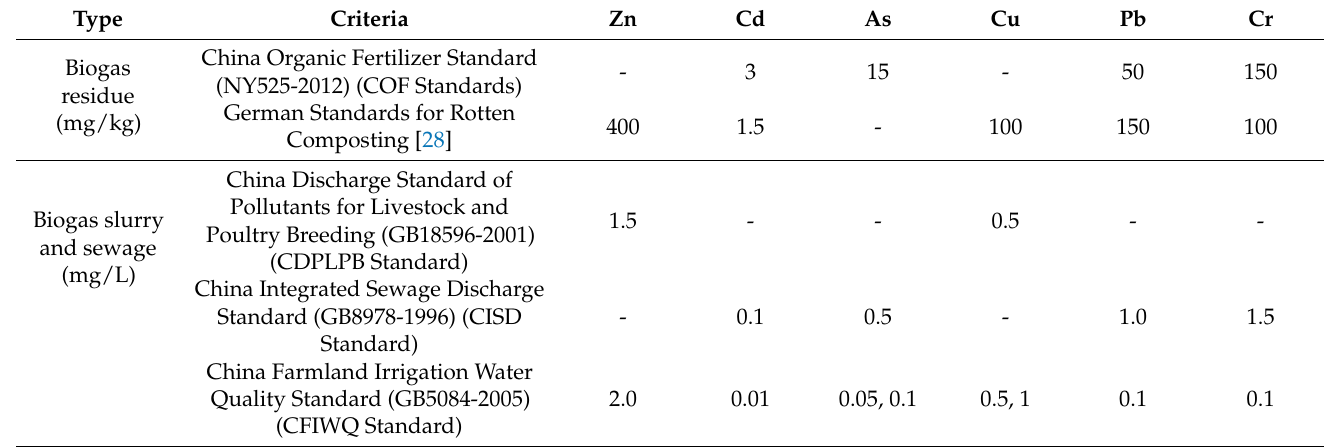
Table 2. Maximum limits of heavy metals in biogas residue, biogas slurry, and sewage.